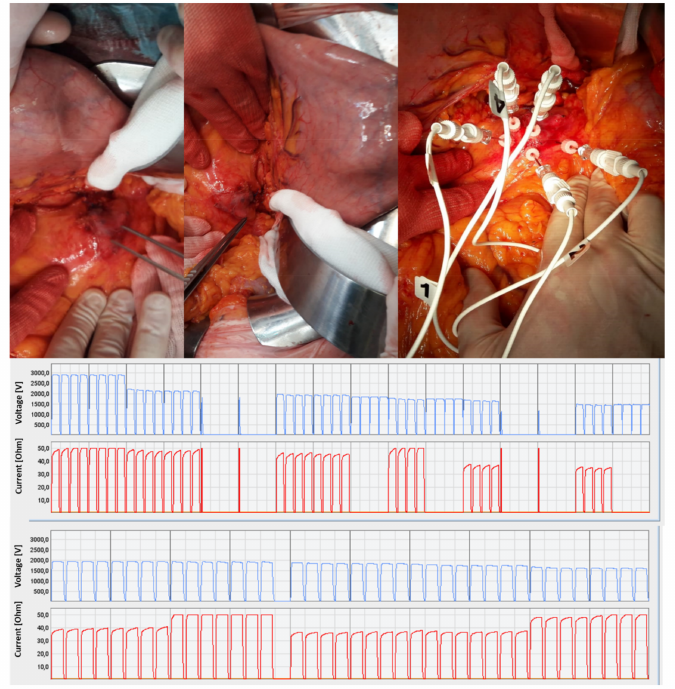
Figure 1. The panels show representative images of the open surgery procedure with electrode insertion in a variable geometry and the delivered electric pulses graphs.